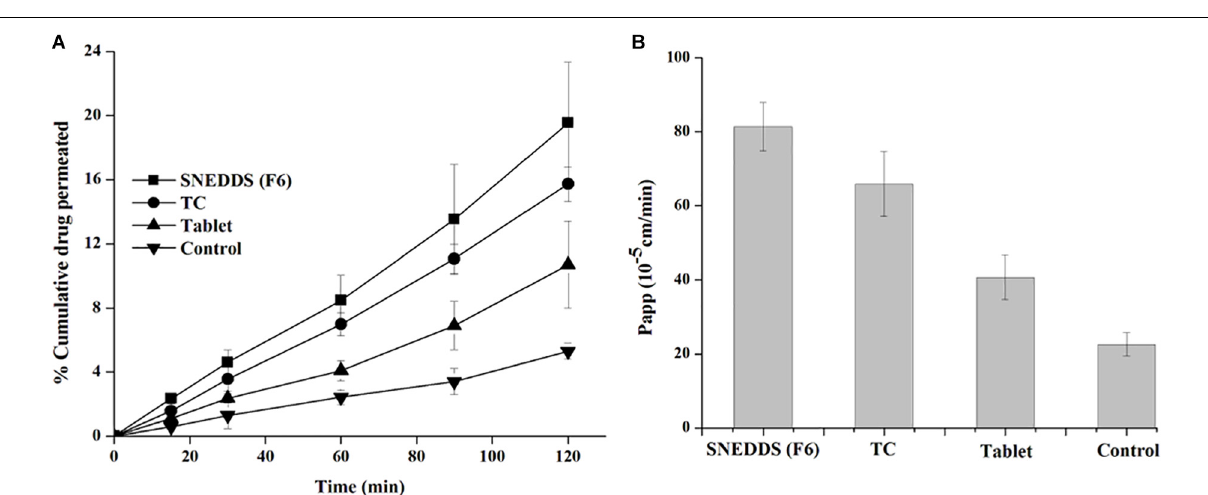
Frontiers in Pharmacology |